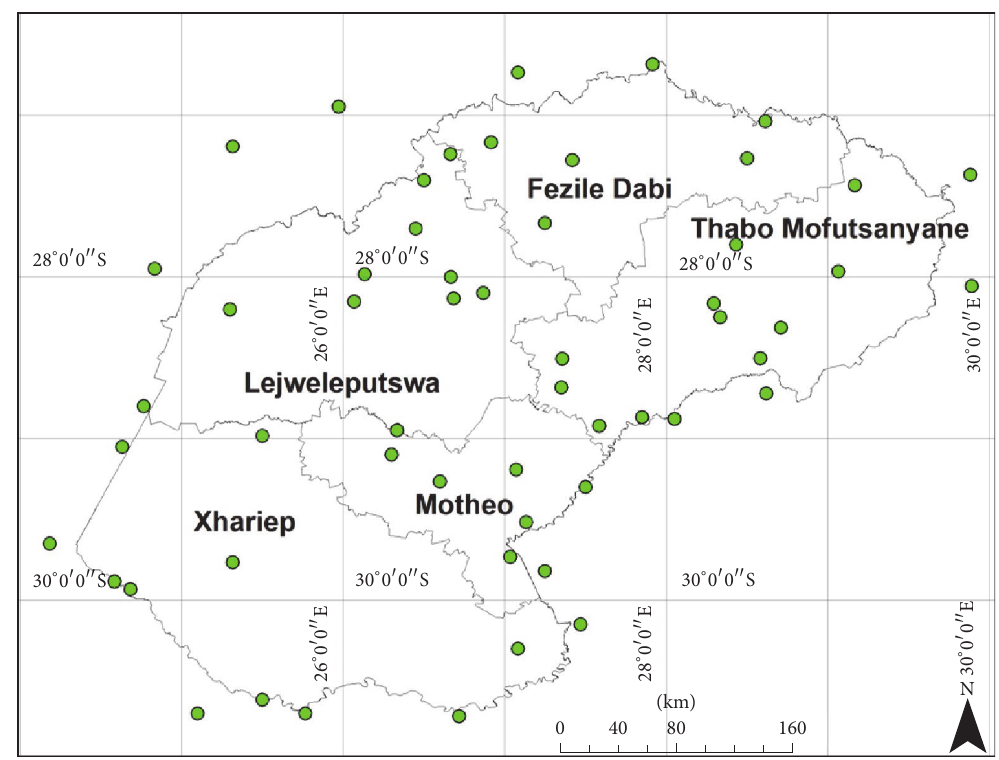
Figure 1: Spatial distribution of climate stations used in maize heat units assessment over the Free State Province of South Africa.